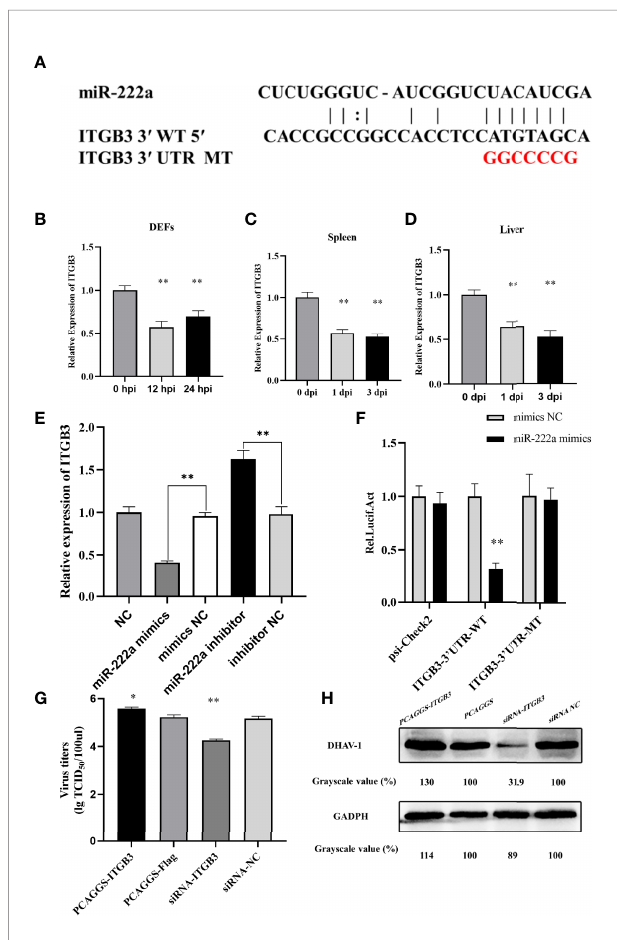
FIGURE 9 | ITGB3 is the target of miR-222a. (A) Schematic diagram of the predicted miR-222a seed sequence for the ITGB3 and the mutated nucleotides are highlighted in red. ITGB3 expression changes in the DEFs (B) , spleen (C) and liver (D) during DHAV-1 infection. (E) A luciferase activity assay detected expression regulation of ITGB3 by miR-222a. WT is representative of wild-type ITGB3, and Mut indicated the ITGB3 with mutations in the region, having complementarity with the seed sequence. (F) . RT-qPCR analysis detected expression regulation of ITGB3 in the DEFs after transfected with miR-222a mimics or inhibitors. DEFs were transfected with the indicated plasmid and then were infected with DHAV-1 at an MOI of 3. Twenty-four hours after infection, viral titers were measured by TCID50 (G) and DHAV-1 viral protein expression were detected by western blot (H) . * indicated P < 0.05 and ** indicated P <